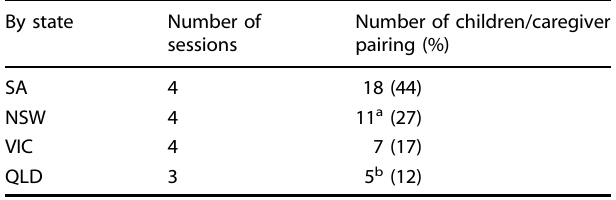
Table 1. Focus group participation by state. Table 2. Asthma pro fi le of participants ( n =